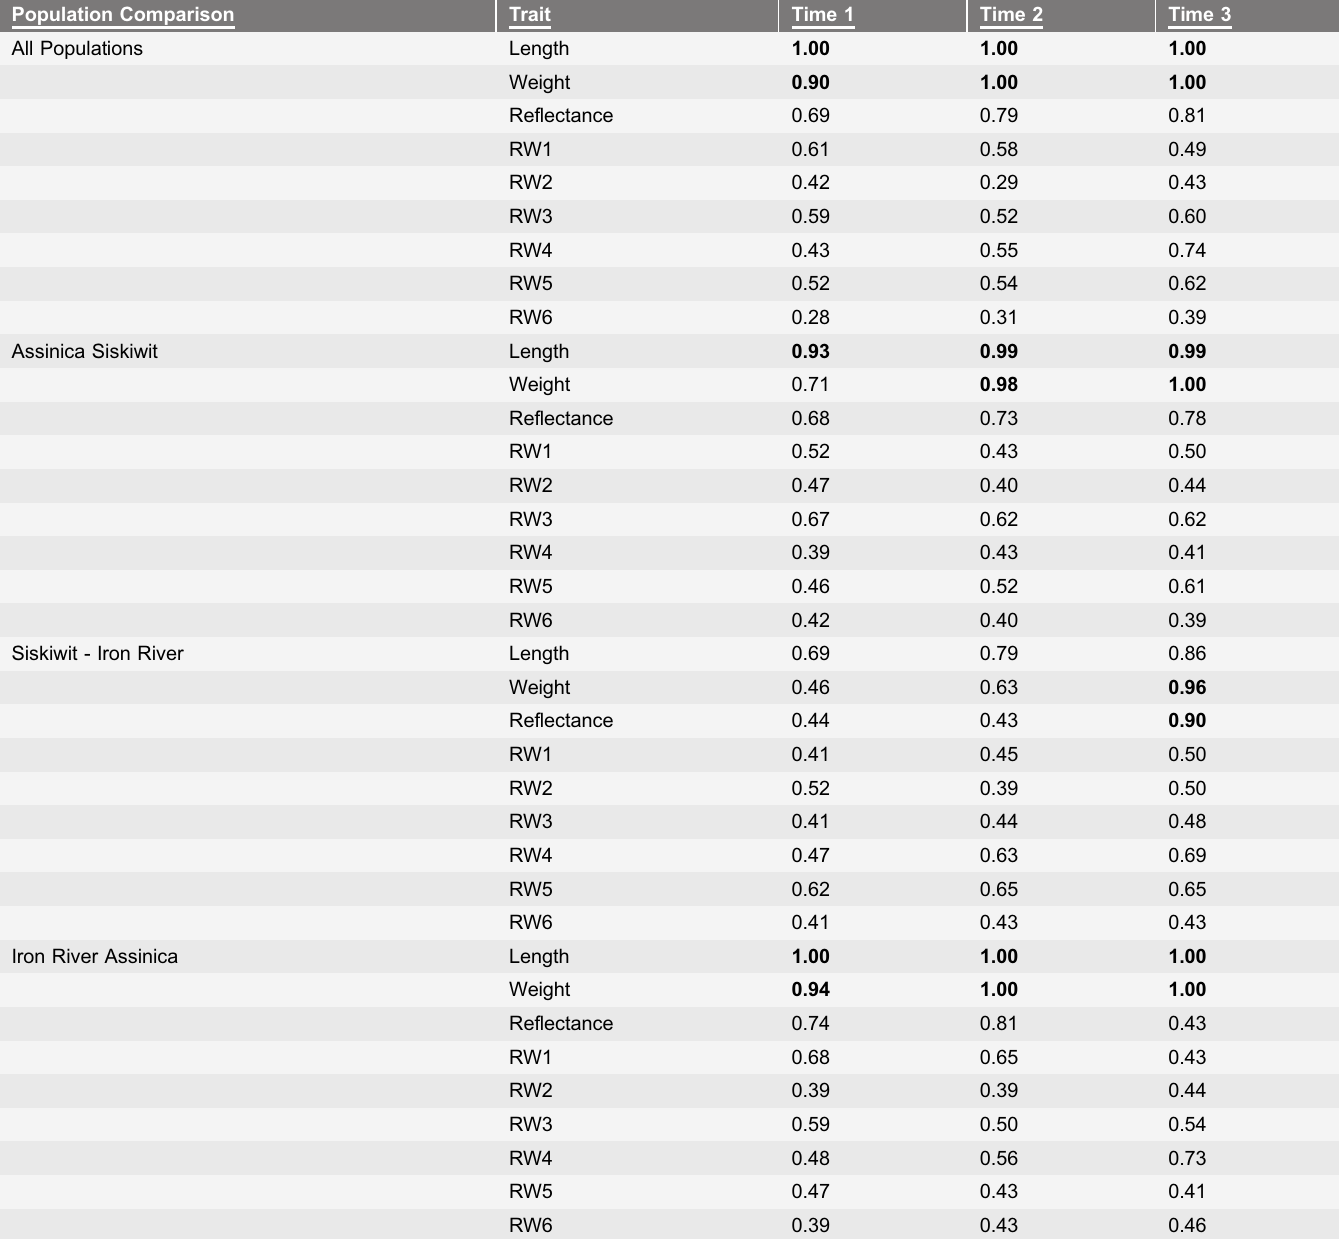
Table 1. Signals of selection (S from driftsel) for univariate traits at each time point for different groupings of populations. Population